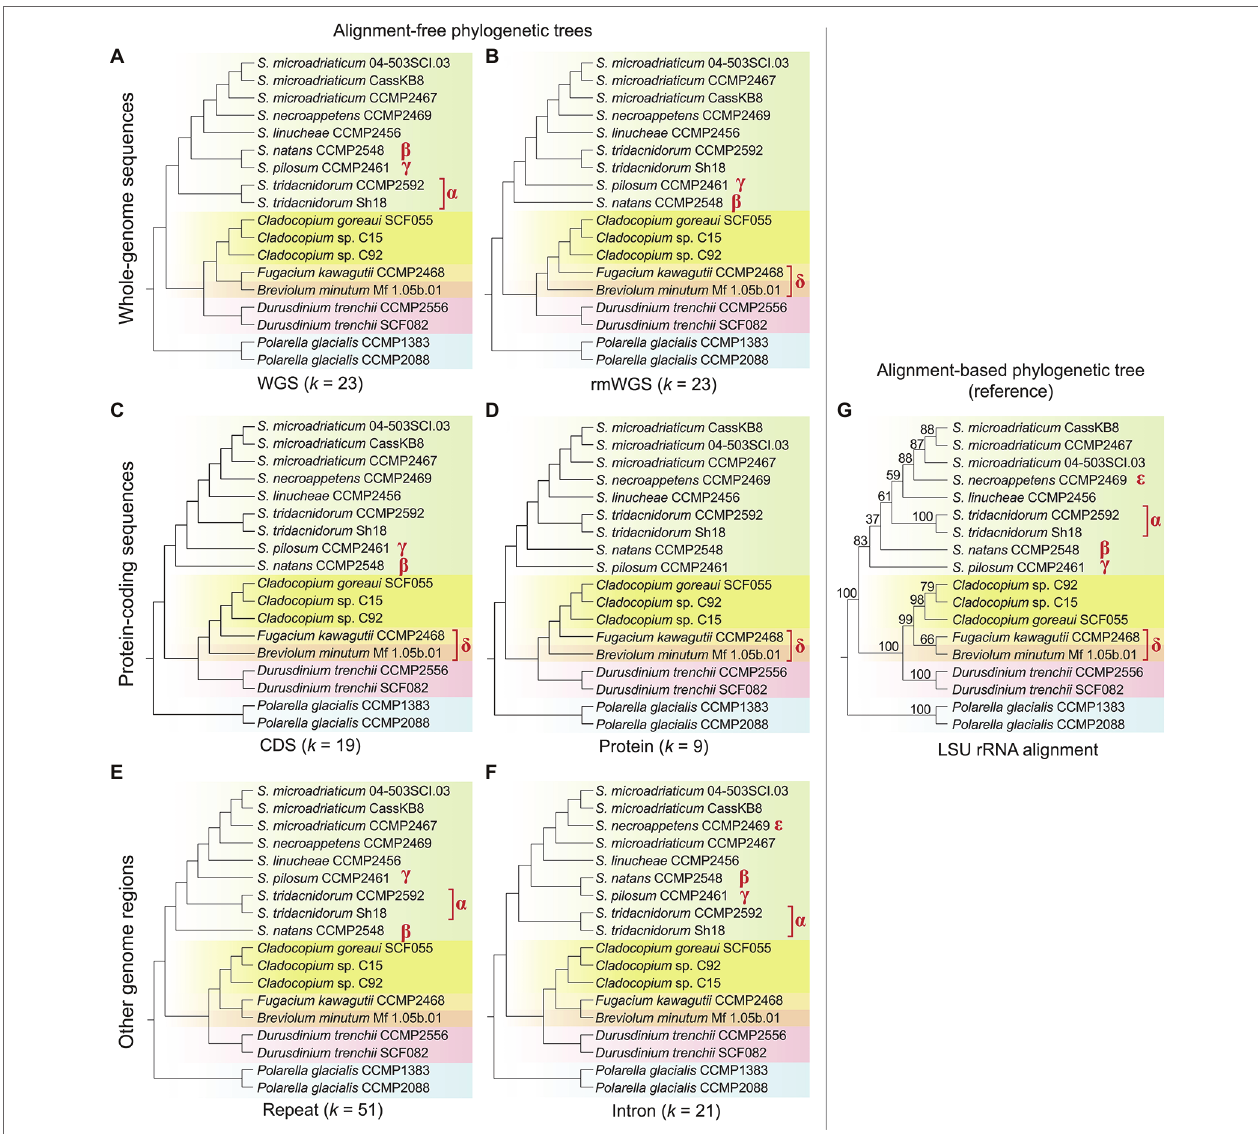
FIGURE 1 | Alignment-free phylogenetic trees of 18 dinoflagellate taxa inferred from: (A) whole-genome sequences (WGS), (B) repeat-masked whole-genome sequences (rmWGS), (C) protein-coding sequences (CDS), (D) the encoded protein sequences, (E) the annotated repeats and (F) the intronic regions. The corresponding k used for each inference is shown at the bottom of each tree. (G) The topology of reference tree inferred from multiple sequence alignment of LSU rRNA, showing ultrafast bootstrap support (from 1,000 sample replicates). All tree topologies are rooted with Polarella glacialis as the outgroup. Differing branching order between each alignment-free tree and the reference tree is indicated with the symbols α , β , γ , δ and ε . Phylogenetic networks of these alignment-free trees are available as Supplementary Data 2